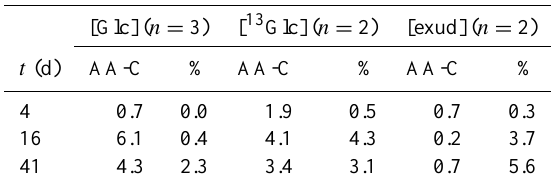
Table 3. Total dissolved hydrolysable amino acids and their contri- bution to organic carbon (AA-C) in µmolL − 1 and percent of total DOC (%) in the [Glc], [ 13 Glc] and [exud] treatments on day 4, 16 and 41. [Glc] ( n =